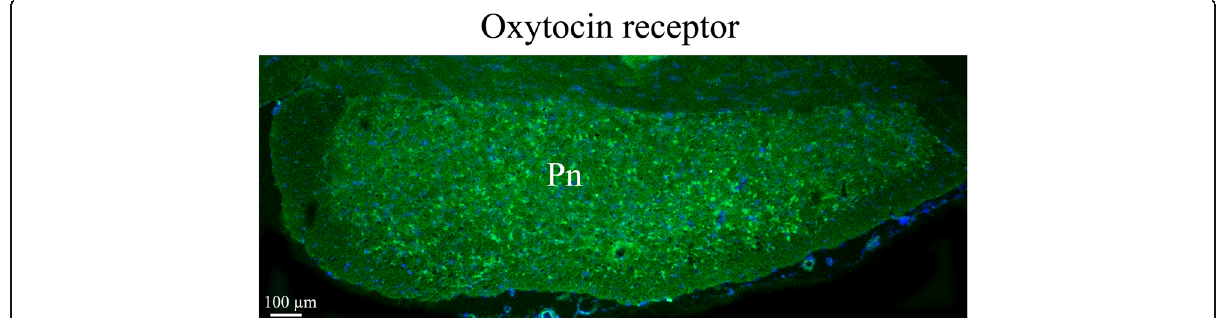
Fig. 13 Oxytocin receptor immunohistochemistry in the pons. Neurons in the pons (Pn) expressed oxytocin receptor in the cell soma